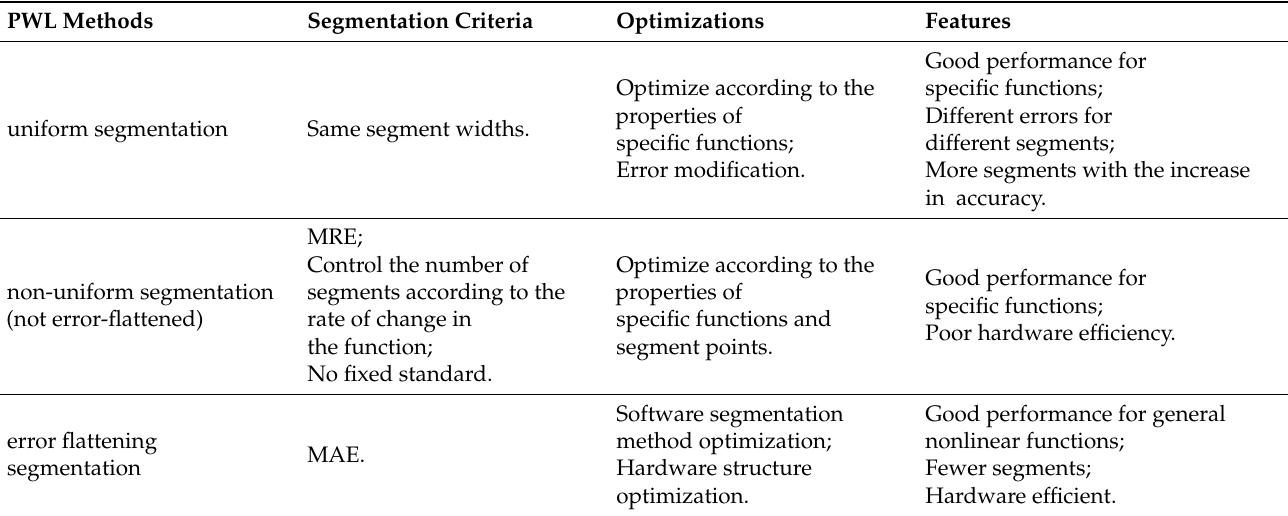
Table 1. The comparison of the different PWL